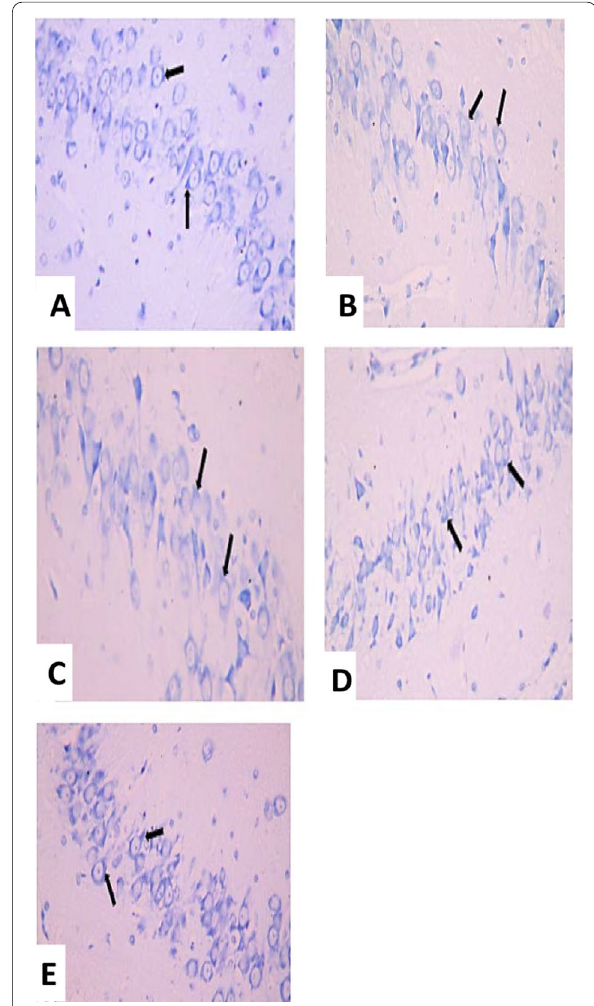
Fig. 2 Toluidine blue stained sections of hippocampus (CA3) region. A Control non ketamine treated group showed pyramidal cells studded with Nissl’s granules. B Ketamine treated rats shows Nissl’s granules of pyramidal cells were less in number compared to control non ketamine treated group. C Tamoxifen/ketamine treated rats appeared studded with more Nissl’s granules compared to control ketamine treated group. D Risperidone/ketamine treated rats appeared studded with more Nissl’s granules compared to control ketamine treated group. E Tamoxifen/risperidone/ketamine treated rats shows Nissl’s granules were significantly increased compared to ketamine treated and risperidone/ketamine treated